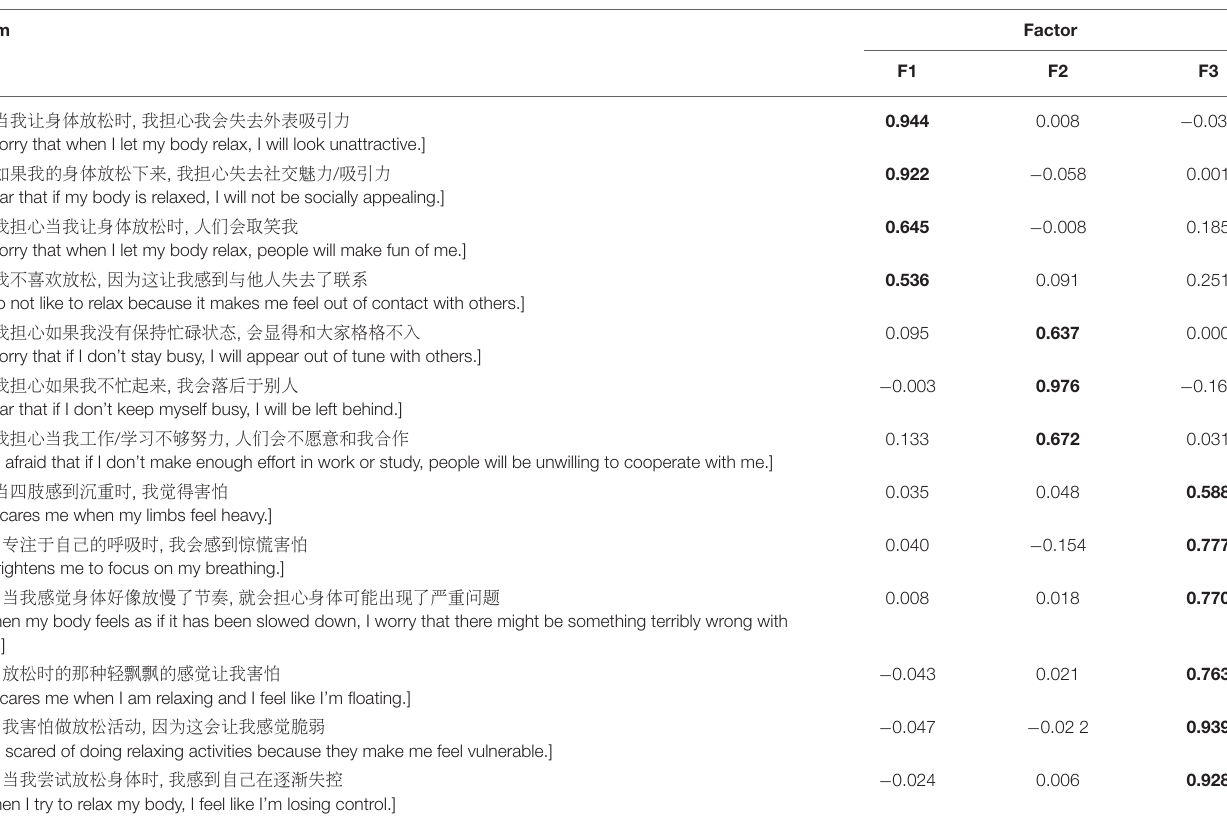
TABLE 4 | Factor loadings for the second three-factor